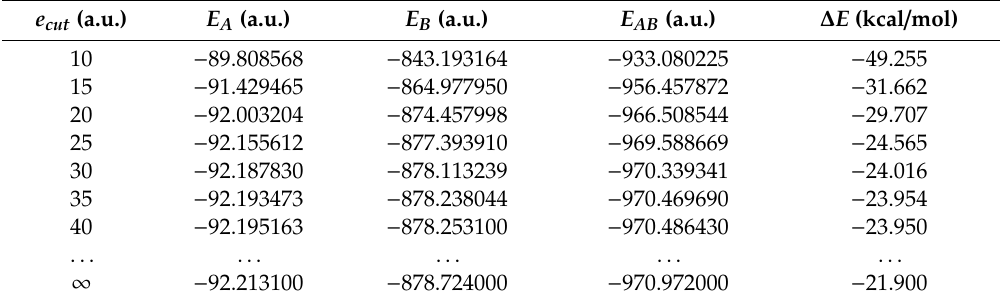
Table 3. Molecular and complexation energies computed with plane-waves for the AB = TEMPO@ β -CD system, as a function of the e cut threshold. The data correspond to the complex optimized with PBE functional and Grimme D2 corrections. The values without the D2 treatment are obtained adding the + 26.76 kcal / mol shift to all ∆ E values. e cut